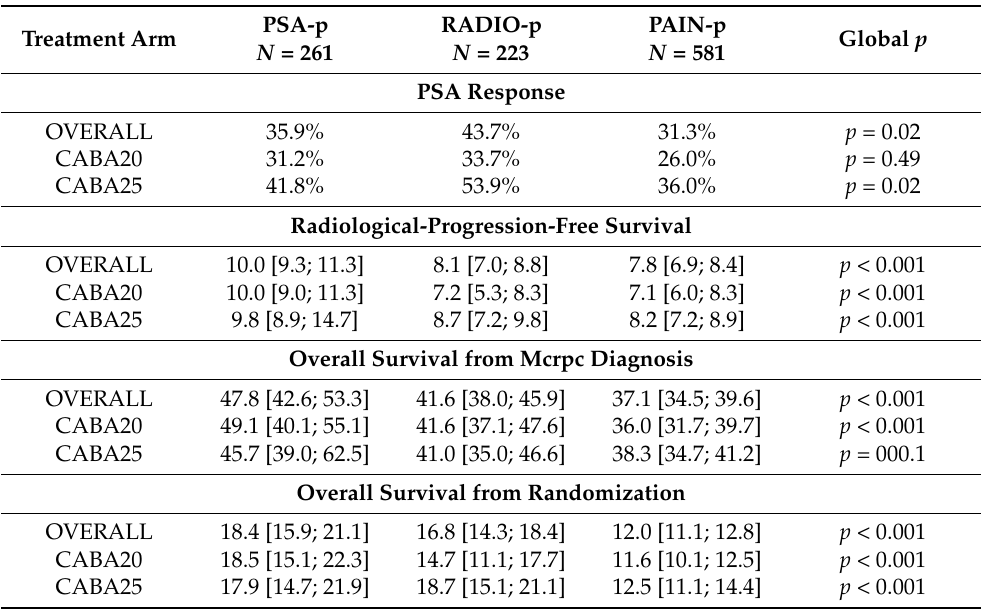
Table 3. PSA response, radiological-progression-free survival, and overall survival from